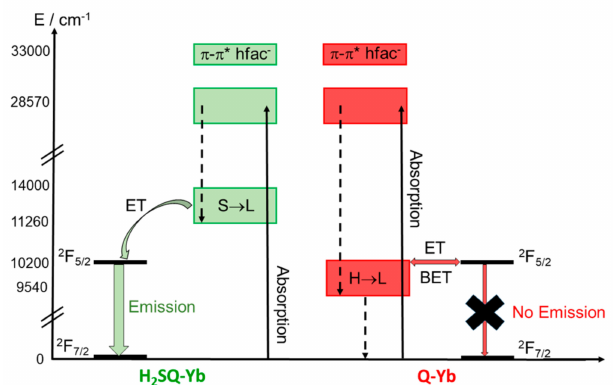
Scheme 2. Proposed sensitization process in H 2 SQ-Yb (left part) and Q-Yb (right part). Dashed lines represent the non-radiative deactivations, ET = Energy Transfer, BET = Back Energy Transfer, H = HOMO, L = LUMO and S =